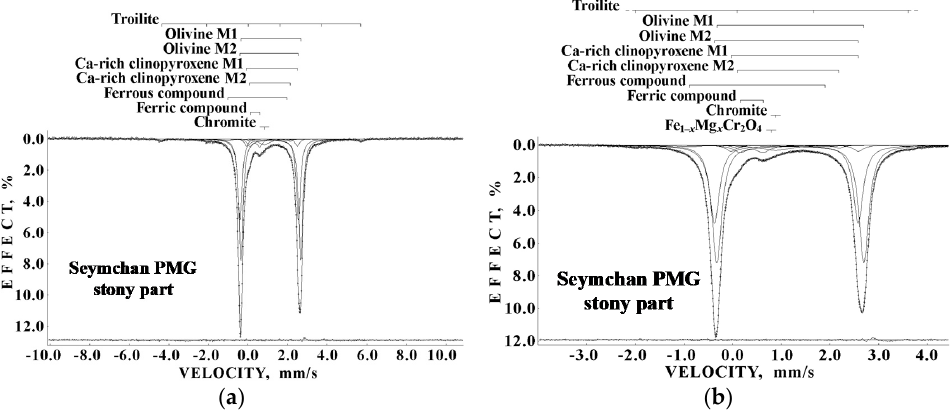
Figure 20. Room temperature Mössbauer spectra of Seymchan PMG stony part measured in 4096 channels and presented in 1024 channels in the large ( a ) and in the small velocity ranges ( b ). Indicated components are the results of the best fits. The differential spectra are shown on the bottom. Adapted from [45].